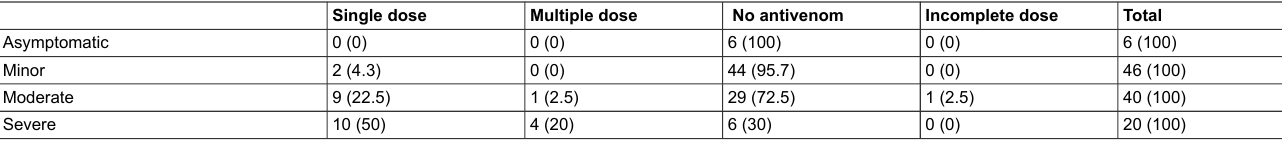
Table 3: Number of doses of antivenom in 112